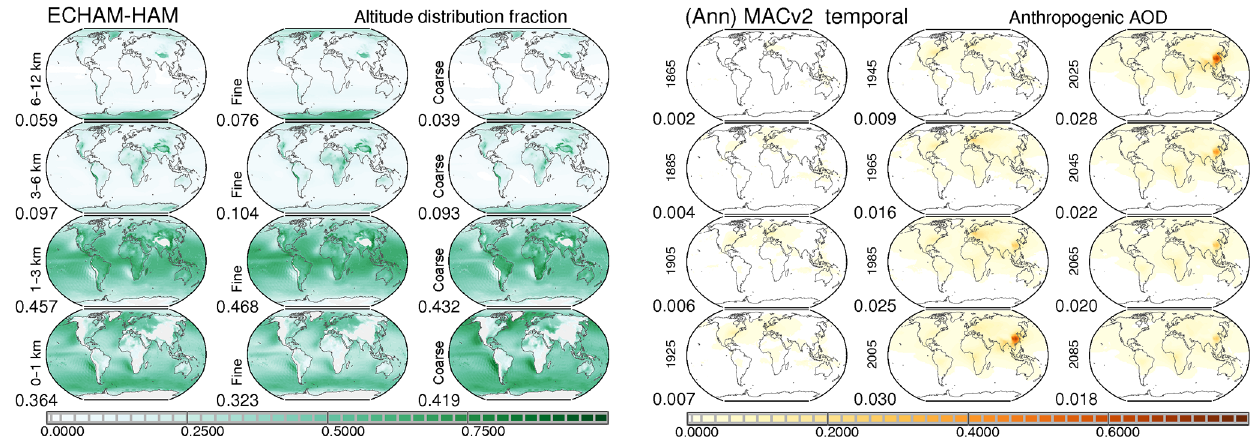
Figure 3. Annual maps for fractional contributions of total, fine-mode and coarse-mode AOD (left frame) for four altitude regimes (0–1, 1–3, 3–6, > 6km above sea level) and for anthropogenic AOD (550nm) for different years from 1865 to 2085 (right frame). Values below the label indicate global